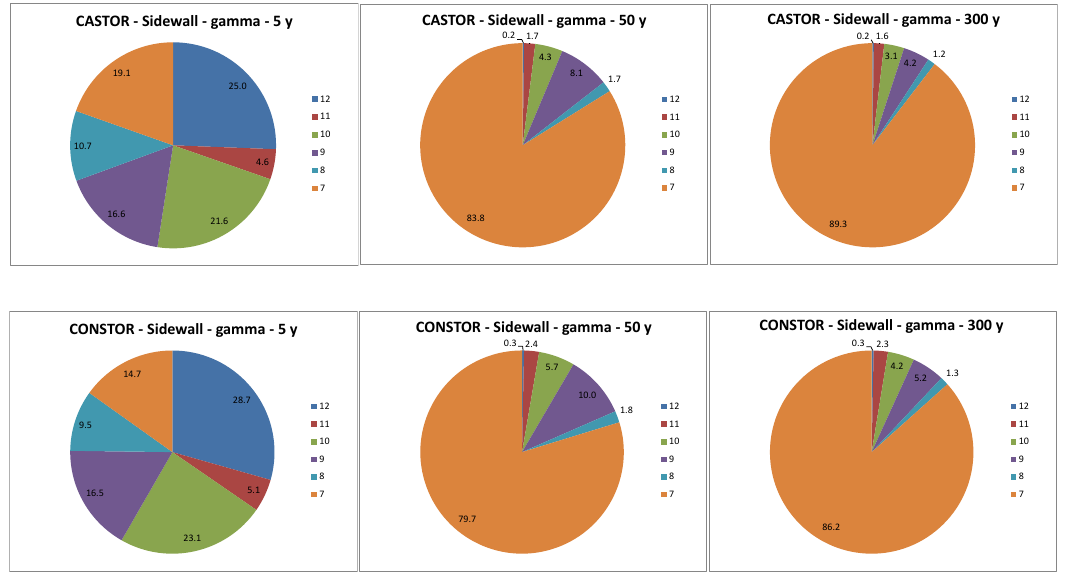
Figure 3. Energy groups that determine the gamma dose rate (low-energy gamma photons are efficiently shielded; the number of high-energy gamma photons is rather small).